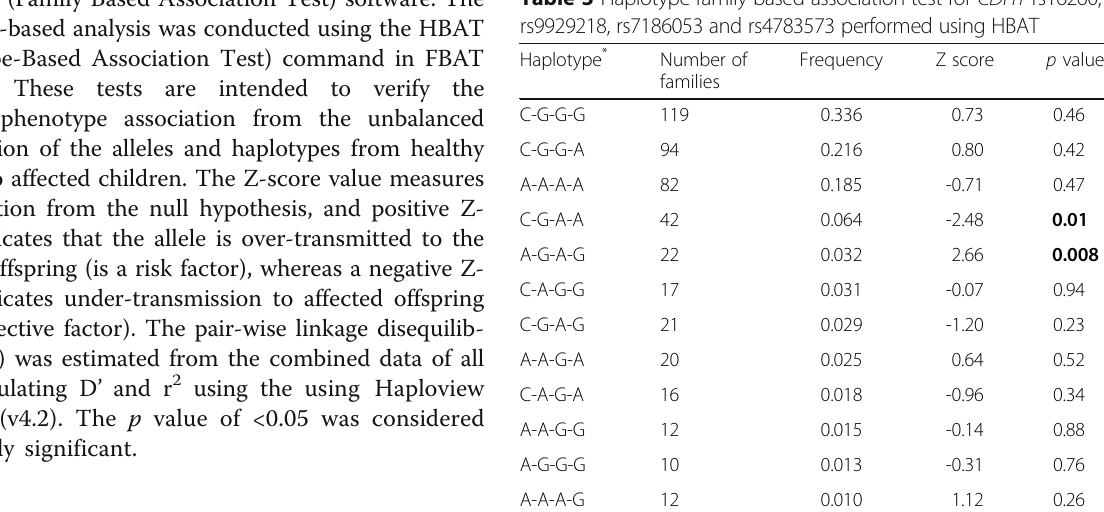
Table 3 Haplotype family-based association test for CDH1 rs16260,